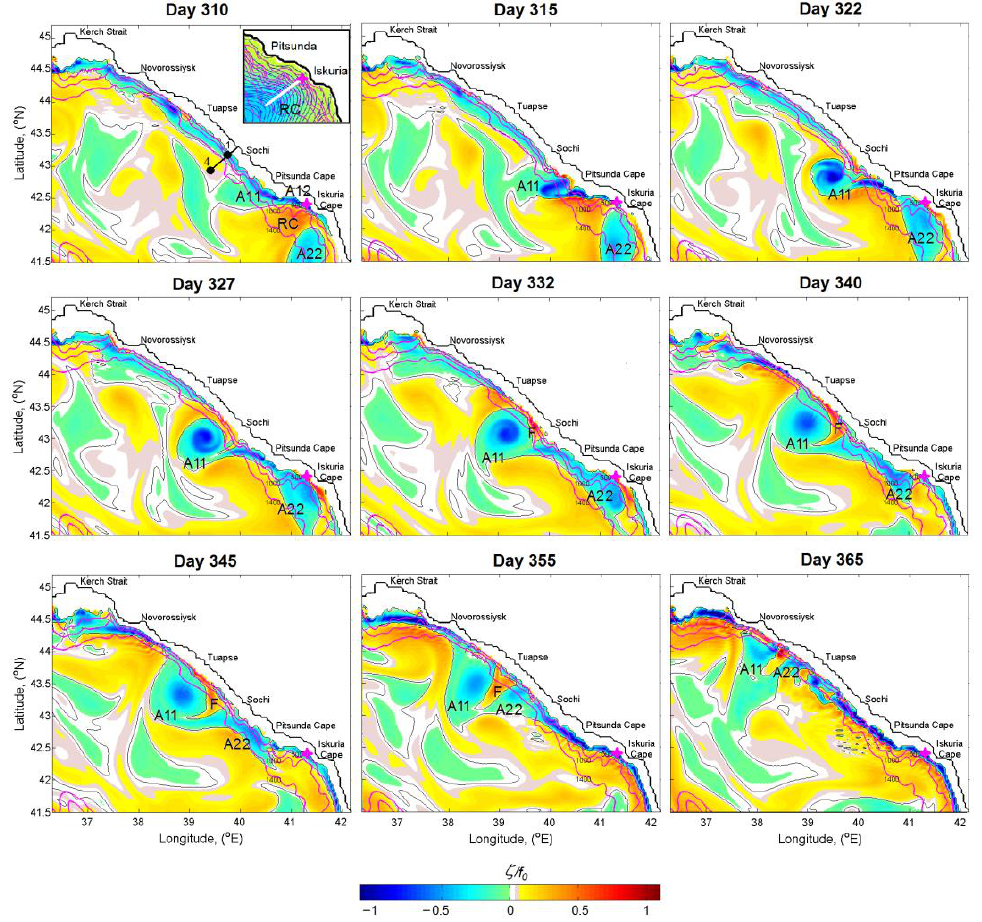
Figure 6. Sequence of vertical vorticity ζ normalized by f 0 at the depth of 50 m illustrates the generation and evolution of the CAE in the period of the transition of circulation from summer to winter of simulated year 39. Julian days are shown at the top. Magenta lines show isobars 500, 1000, and 1400 m. A11 and A22 denote the CAE and the Inguri–Rioni AE, respectively. F denotes coastal upwelling filaments. The inset in the panel ‘day 310’ shows streamlines of the RC abeam of the Iskuria Cape. The magenta star shows the site A12 where the generation of the CAE is triggered, while the white bar shows the submarine ridge nearest this site. In the panel, ‘day 310’ and numbers 1, 4 denote the sites used for kinetic energy spectra study (as in Figure